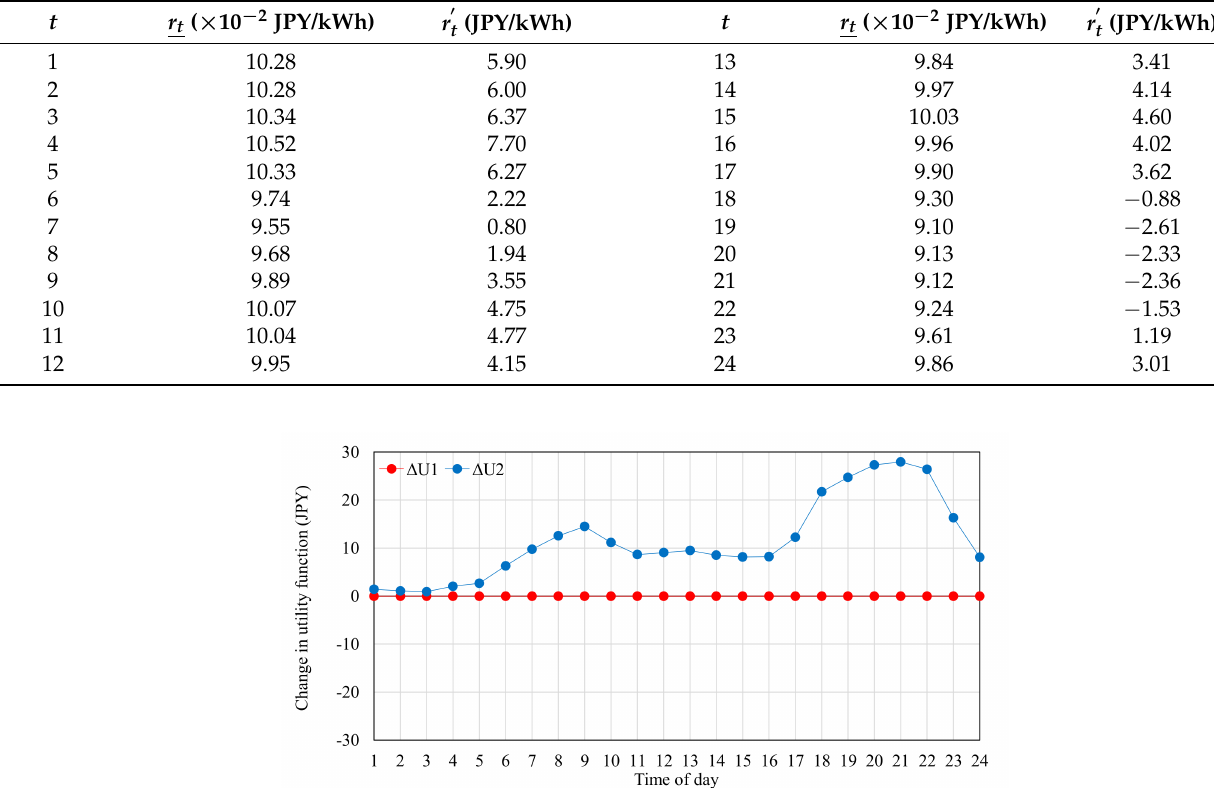
Table 7. Numerical simulation results of incentive-based DRs under scenario 2.